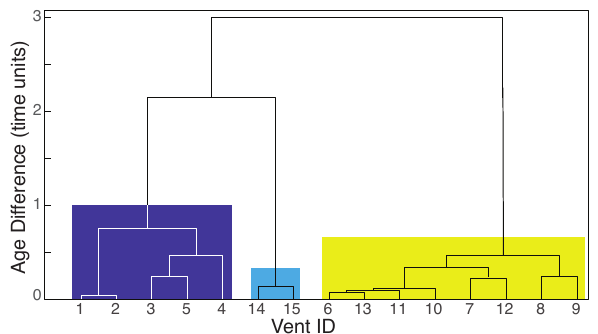
Figure 5: Dendrogram for example vent data ages from Figure 4. The boxes indicate the age clusters, whose colours correspond with key from Figure 4. between each point is measured, the two points with the smallest distance between them are linked (the next step up in the tree), and this process continues until all points are linked (the top of the tree, Figure 5). The out- put of this process provides the organisational founda- tion from which we are able to temporally cluster the data, which occurs in Step 2.